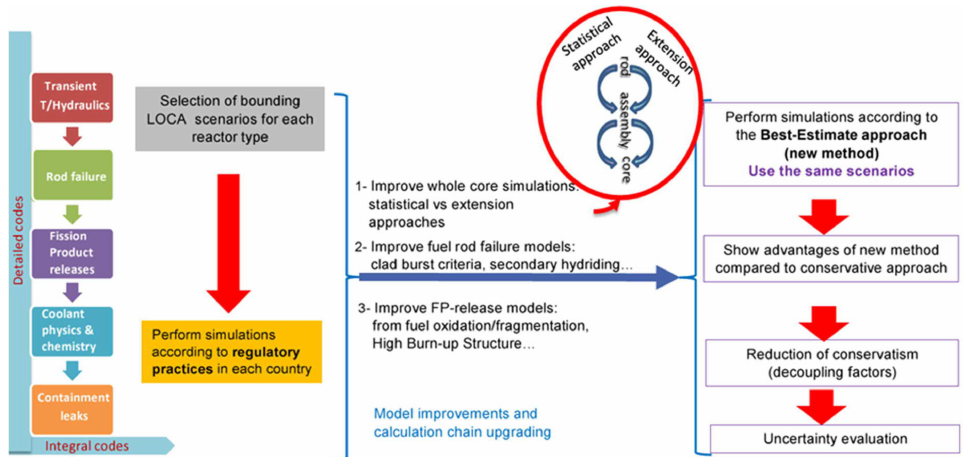
Fig. 4. R2CA methodology for best-estimate evaluation of releases during a LOCA transient.